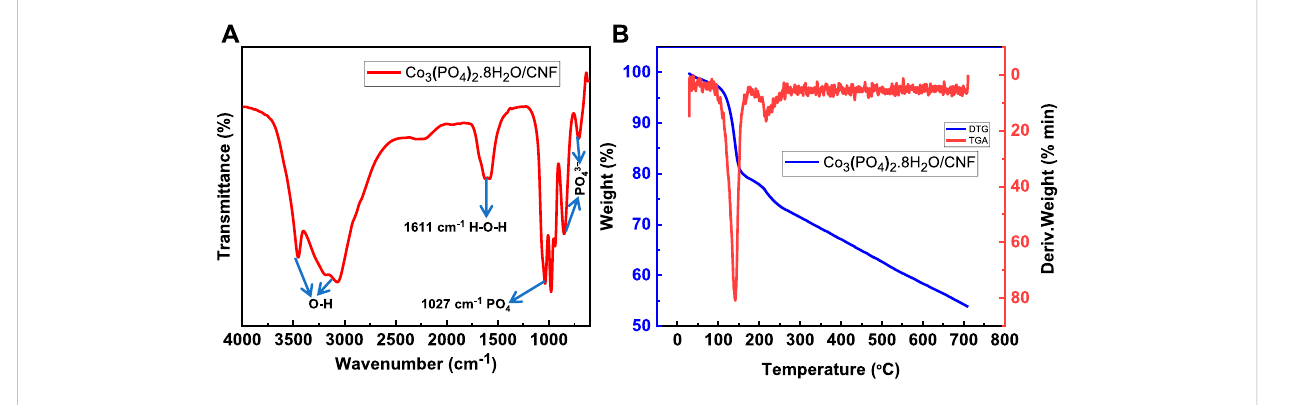
FIGURE 3 (A) FTIR analysis, and (B) TGA (blue, left axis) and DTG (red, right axis) analysis of Co 3 (PO 4 ) 2 · 8H 2